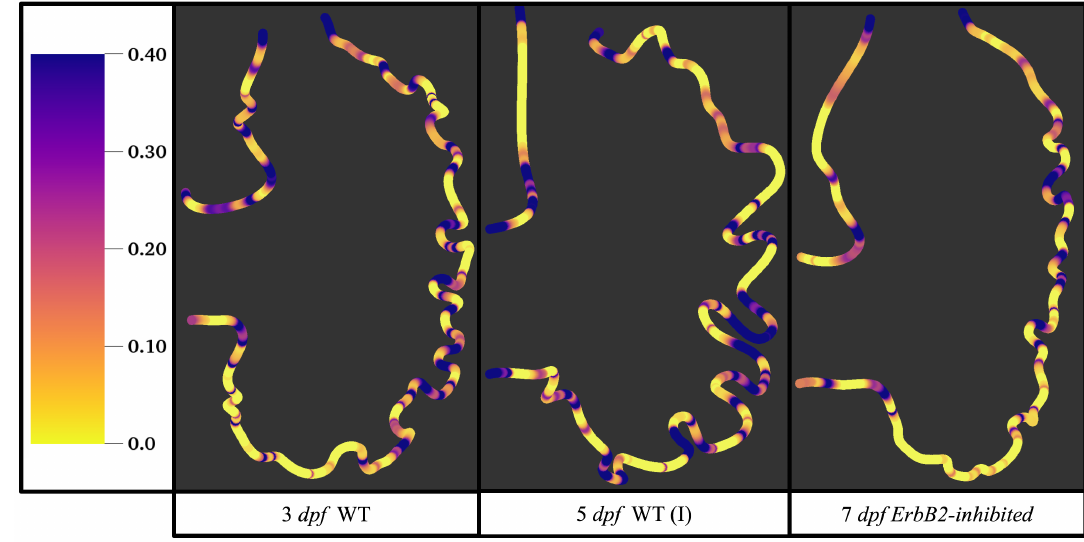
Figure 15. Plot giving the oscillatory shear index (OSI) over the ventricle during the 4th pulsation cardiac cycle for Re = 1. High OSI occurs in intertrabecular regions and on the trabeculae